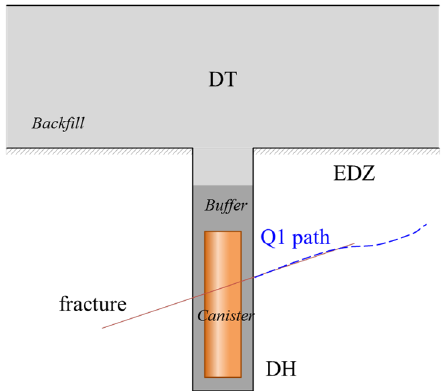
Figure 1. The schematic concept of the disposal facility and Q1 pathways for radionuclides to leave from the DH based on the KBS-3 disposal system. The fracture (in red color) interests the DH.